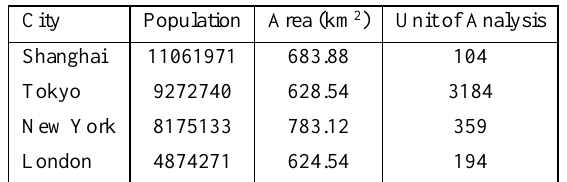
Table 1. Basic information of the study areas